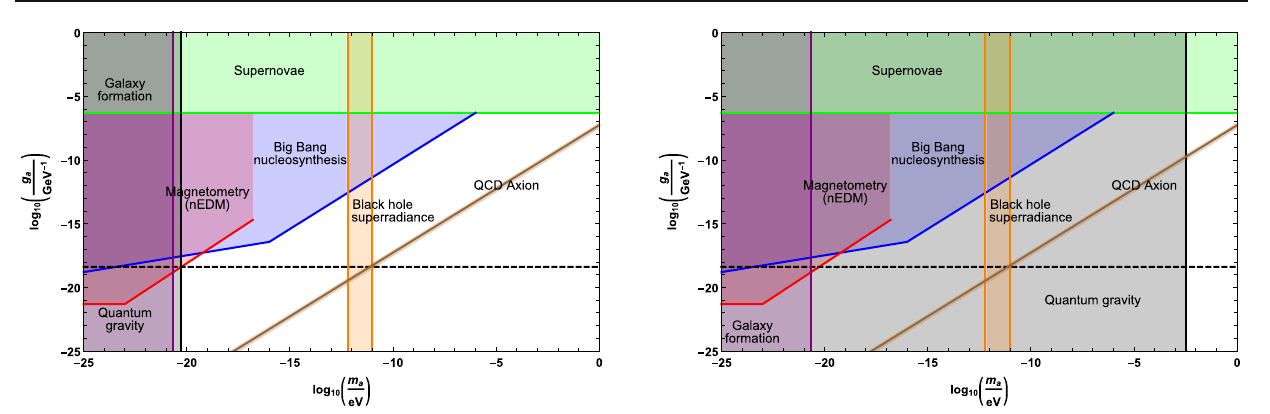
Fig. 3 Parity violating quantum gravity. Limits on the linear axion interaction g a = c 3 /(cid:4) 3 as a function of the mass of the axion m a . Green: limits from supernovae measurements [54]. Blue: limits from the big bang nucleosynthesis [20,55–58]. Red: limits from magnetom- etry experiments [25,45]. Purple: limits from galaxy formation, quasar lensing and stellar streams [48–53]. Orange: limits from the superra- diance instability of black holes [59], however note that these bounds can be avoided, if the self-interaction of the axion-like particle is suffi- ciently strong [60]. Brown: predicted value of the QCD axion [61,62]. Black: axion masses below m a (cid:3) 3 × 10 − 3 eV are excluded by parity violating quantum gravity as discussed in this paper. Dashed black line: reduced Planck